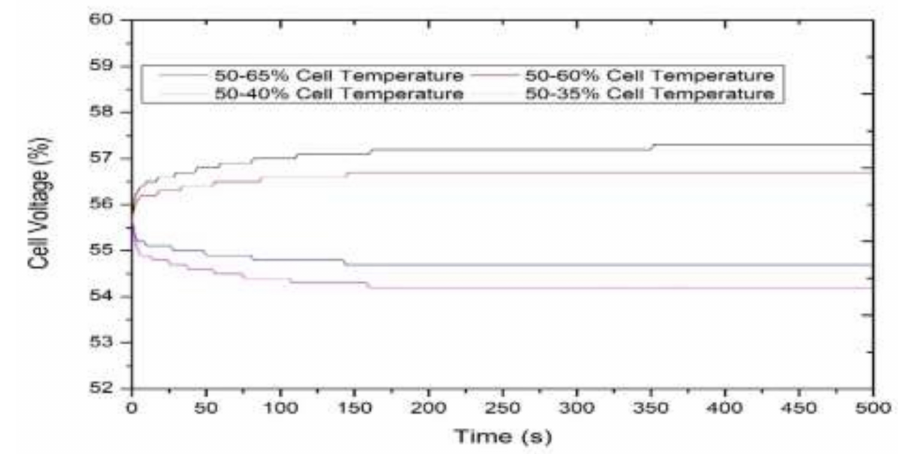
Figure 7. Step response of DMFC at 50% of the operating